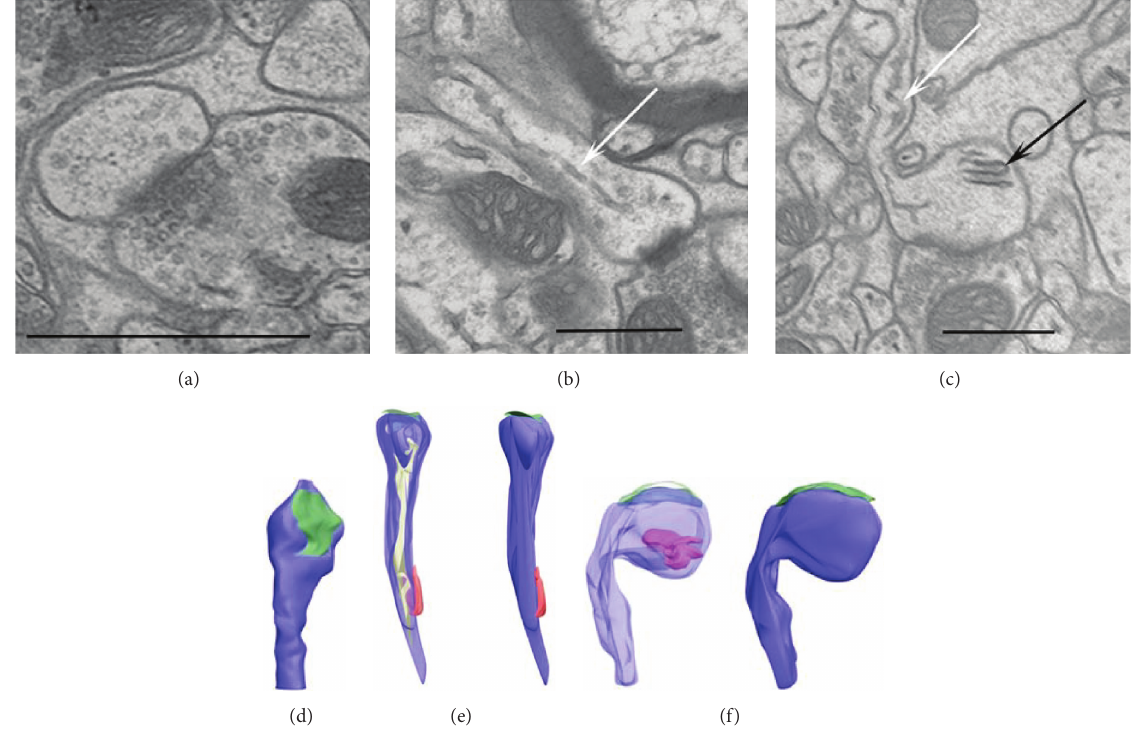
Figure 1: 3D serial section EM reconstruction of three spine types from B2 barrel hollow, also shown in single electron micrographs: sER- free spine (a), spine containing sER (b), and spine containing spine apparatus (c). White arrows indicate sER ((b) and (c)) and black arrow indicates spine apparatus (c). (d)–(f) show reconstruction of dendritic spines (blue): excitatory synapses (green), inhibitory synapse (red; only (e)), smooth endoplasmic reticulum (yellow; (e)), and spine apparatus (red; (f)). Scale bars: 0.5 𝜇 m.